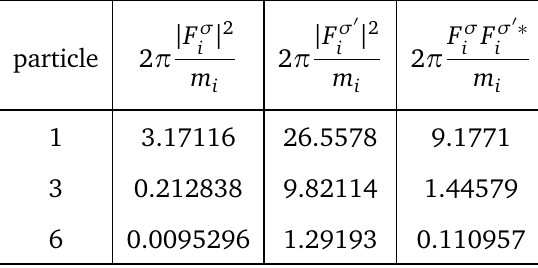
Table 7.1: One-particle weights in the contributions to the DSF